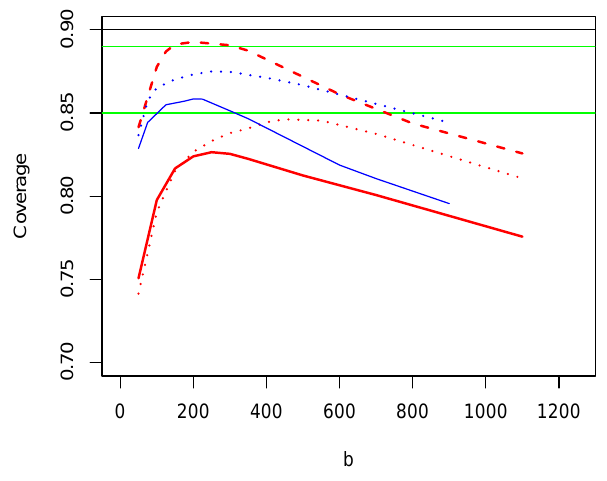
Fig. 3. Actual coverage probabilities of 90% subsampling CIs for the skewness (red) and variance (blue) of nonlinear time series ( 6) at a = 0 . 145: n = 2048 (solid), n = 4096 (dotted), calibrated CIs at n = 2048 (dashed). Horizontal green lines denote 0.85 and 0.89